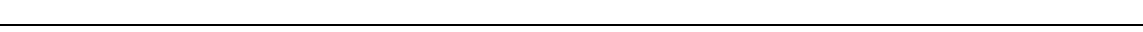
Fig. 3 Attenuating mutations in segment 5 impact coordinated genome packaging. a Confocal microscopy images depicting the localization of nucleoprotein (NP) 8 h post infection (hpi). MDCK cells were infected with the indicated virus (white text), and NP was identi fi ed using the MAb HB65 and Alexa-488-conjugated goat-anti-mouse secondary antibody by immuno fl uorescence. Cell nuclei are stained with DAPI. Panels depict the merged image of DAPI and NP staining. Fields are representative of two independent experiments. Scale bar represents 25 µ m. b Dual-luciferase reporter assay to assess viral transcription and genome replication, each combination of plasmids was assessed 3 – 5 times with corresponding the WT-PR8 combination. (n.s., not signi fi cant by one-way ANOVA with multiple comparisons correction (Kruskal – Wallis)). c Mean fl uorescence intensity (MFI) of NP in virally infected MDCK cells (MOI = 0.05, experiments were performed twice in duplicate) as revealed by fl ow cytometry. (n.s., not signi fi cant by one-way ANOVA with multiple comparisons correction (Kruskal – Wallis)). d Viral titer (TCID 50 ml − 1 ) of 4 HA-units of WT-PR8 and mutant viruses. Results are the average + s.e. m. of three viral titrations and two HA assays per infectious virus titration. (* P < 0.05; n.s., not signi fi cant by unpaired t test). e Relative abundance of genome segments in puri fi ed WT or mutant viruses. All segments were compared to segment 7 (M) vRNA and normalized to the average of WT-PR8 values using the 2 -ddCt method 22 . Bars represent the mean of 3 – 6 independent virus preparations + s.e.m. (* P < 0.05; n.s., not signi fi cant by one-way ANOVA with multiple comparisons correction (Kruskal – Wallis)) f Proportion of infected cells co-expressing of matrix (M) and NP proteins in singly infected MDCK cells (MOI = 0.05) 16 hpi as revealed by fl ow cytometry. The average percentage of co-expression was calculated from two experiments performed in duplicate. (n.s., not signi fi cant by one-way ANOVA with multiple comparisons correction (Kruskal –